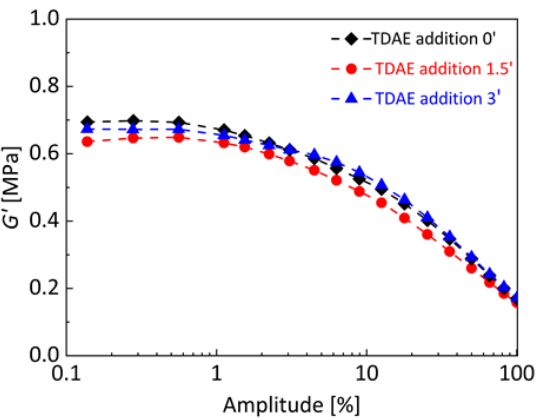
Figure 3. Storage shear modulus ( G ′) of uncured silica-filled SBR/BR binary blends at different TDAE addition time. The analyses were carried out with 10 Hz frequency and at 80 °C.